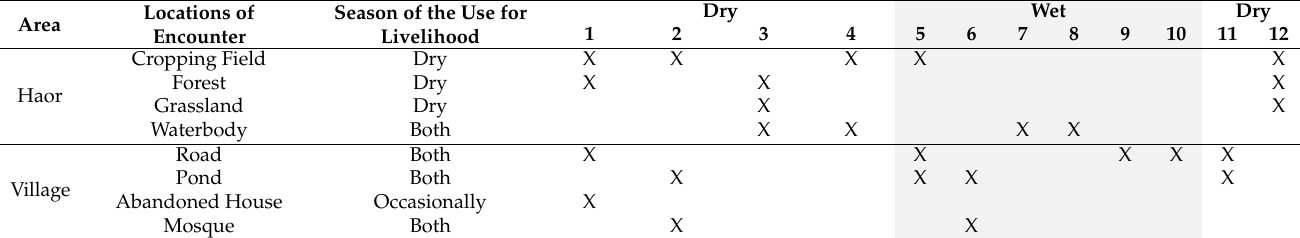
Table 2. Locations and months of human–fishing cat encounters in Hakaluki